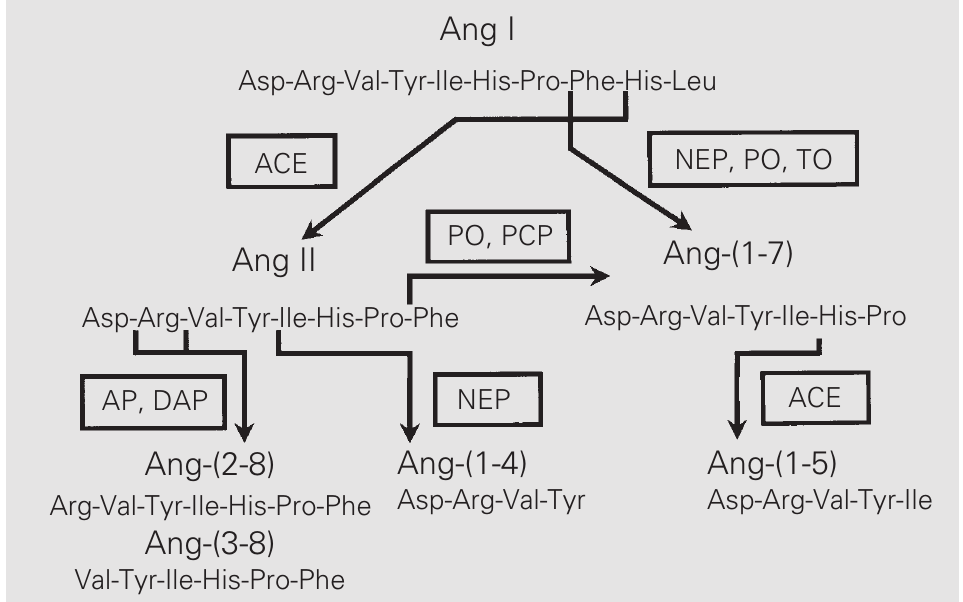
Figure 1 - Pathways for the gen- eration and metabolism of an- giotensin peptides. Angiotensin I (Ang I) is processed to biologi- cally active products through dis- tinct enzymatic pathways. Ang II is formed by the hydrolysis of the Phe 8 -His 9 bond of Ang I by angiotensin converting enzyme (ACE). Ang II is further pro- cessed by aminopeptidases (AP) or dipeptidyl aminopeptidases (DAP) to yield the active metabo- lites Ang-(2-8) and Ang-(3-8). Ang-(1-7) is formed by the hy- drolysis at Pro 7 -Phe 8 of Ang I by several endopeptidases includ- ing neprilysin (NEP), thimet oli- gopeptidase (TO) and prolyl oli- gopeptidase (PO) and from Ang II by PO and prolyl carboxypepti- dase (PCP). Ang-(1-7) is hydro- lyzed at the Ile 5 -His 6 bond by ACE to yield Ang-(1-5); Ang II is cleaved at Tyr 4 -Ile 5 by NEP to yield